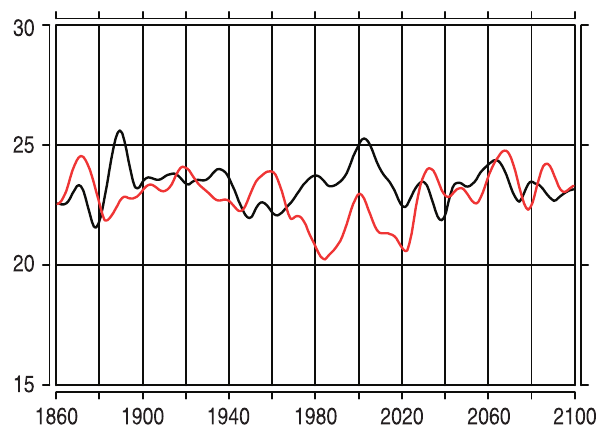
Fig. 1. Time series of the maximum overturning (Sv) in the North Atlantic for the control integration with present-day greenhouse gas concentrations (black line) and the transient greenhouse warming simulation (red